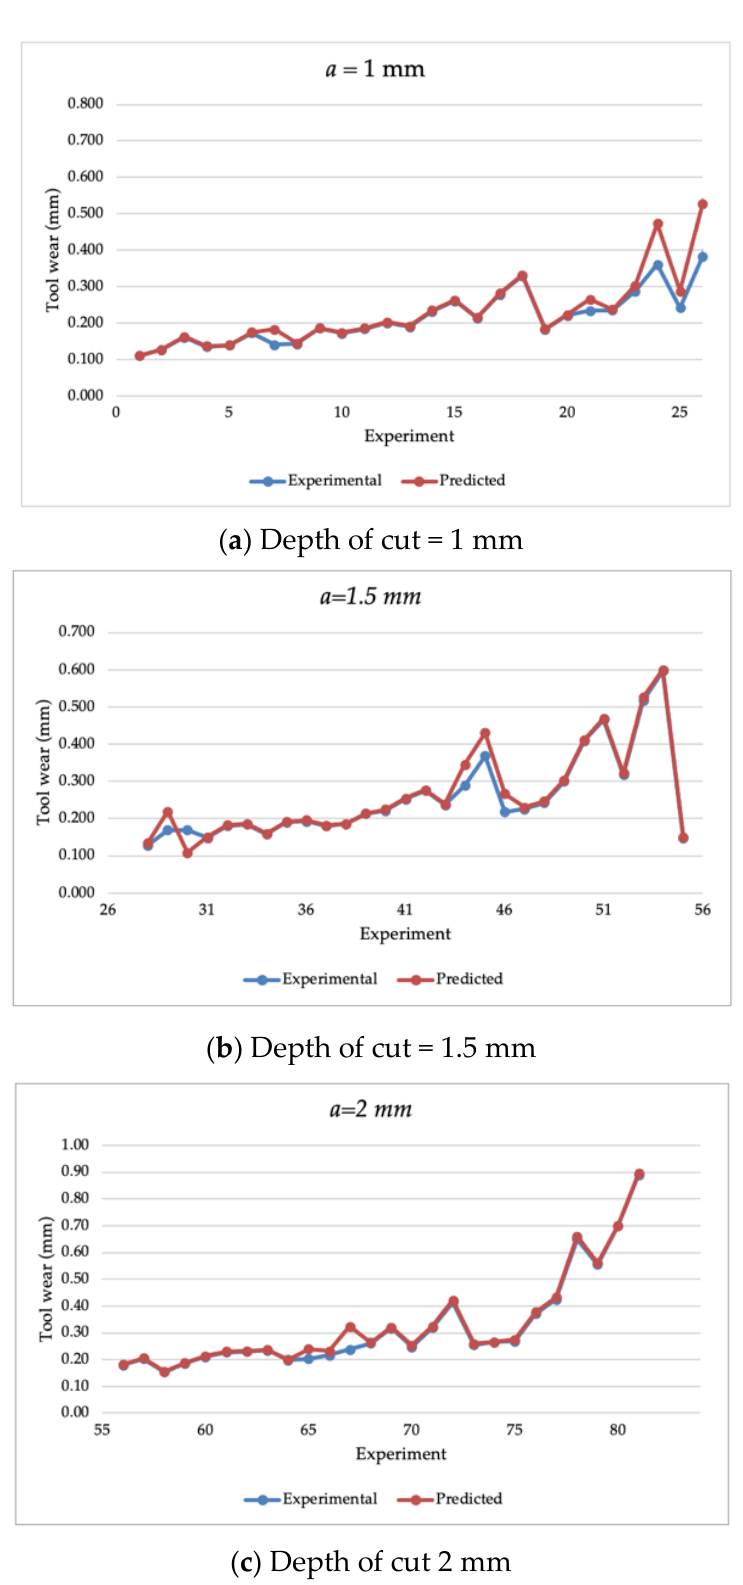
Figure 3. The estimated tool wear of the training dataset parameters in the CVD coated cutting tool with a depth of cut of ( a ) 1 mm, ( b ) 1.5 mm, and ( c ) 2 mm.